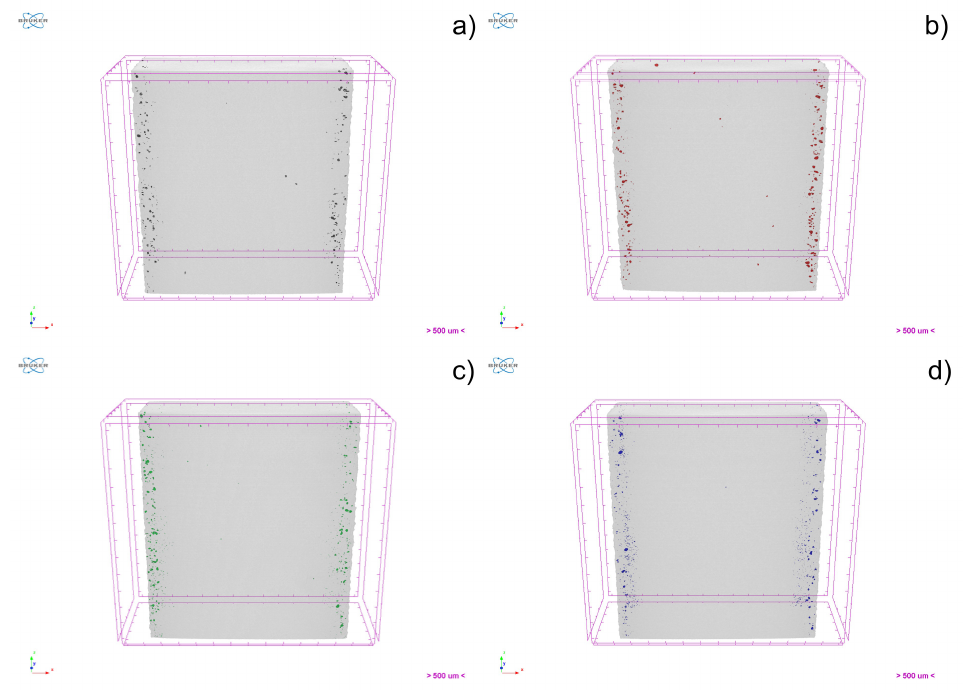
Figure 6. 3D visualization of the pores location within the 3D object volume for 316L ( a ), 630 ( b ), 420 ( c ) and 440C ( d ).